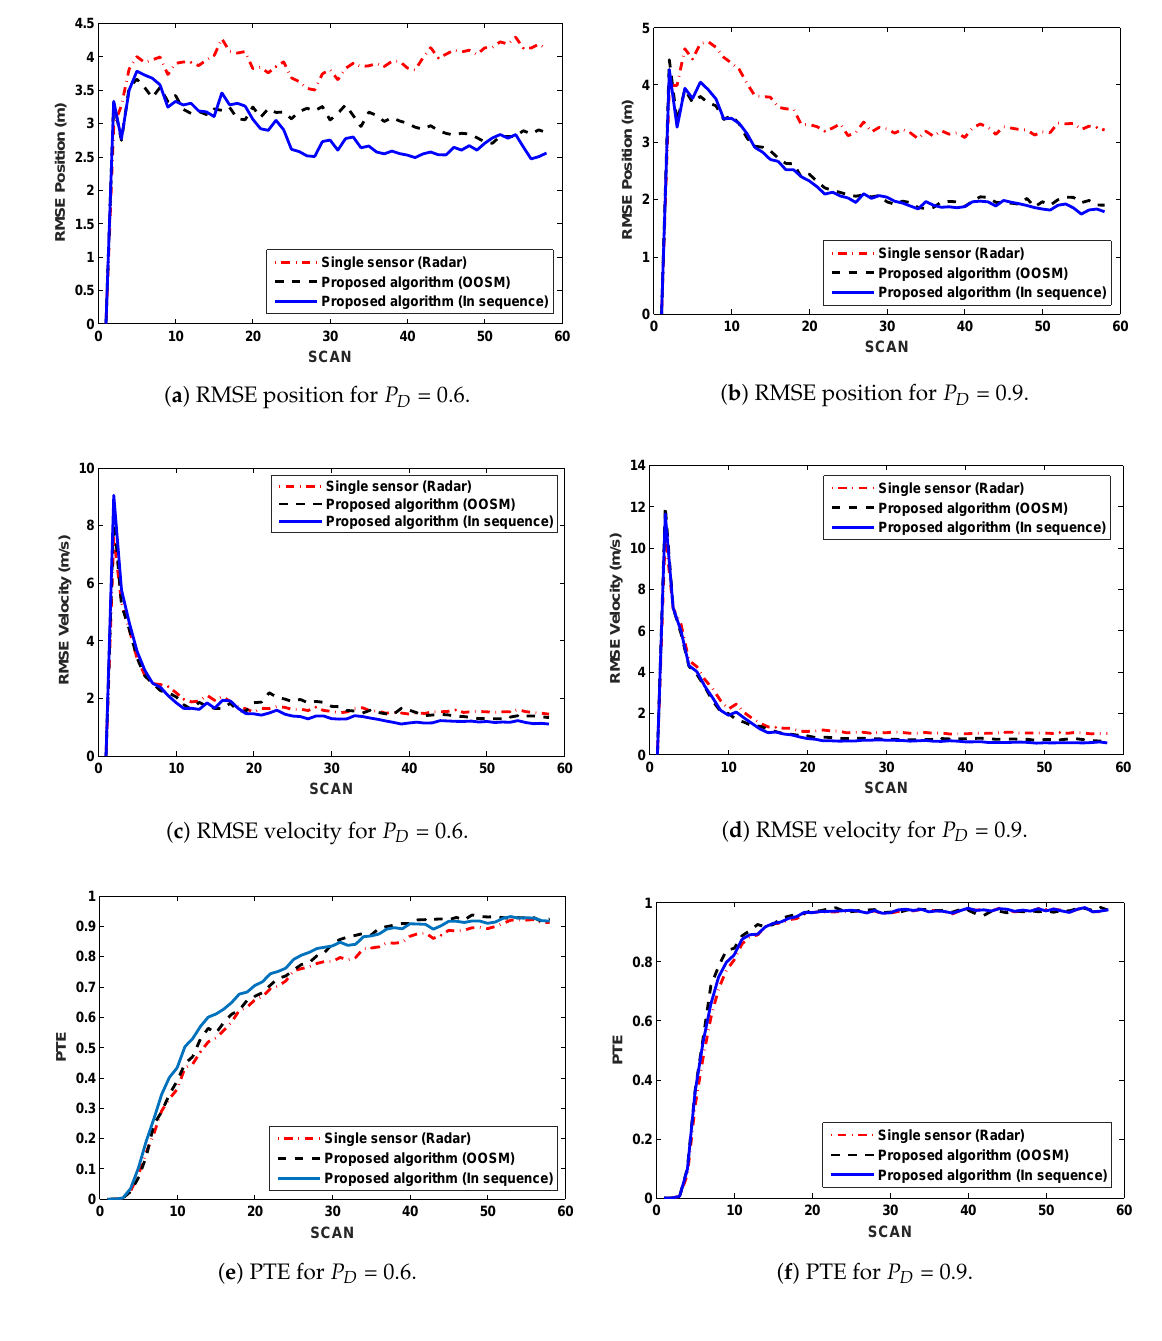
Figure 3. Comparison of RMSEs and Probability of Track Existence (PTE) for P D = 0.6 ( Left ) and 0.9 ( Right